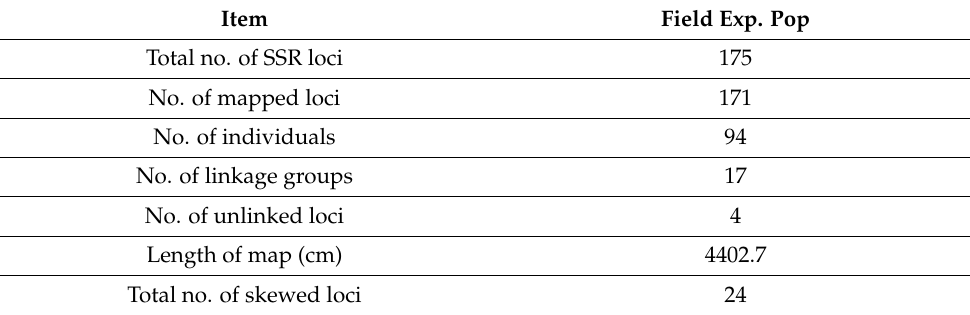
Table 5. Basic characteristics of the genetic map.